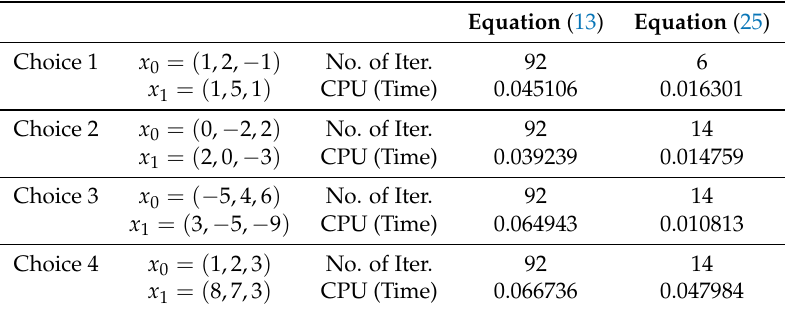
Table 1. Using Equations (13) and (25) with different choices of x 0 and x 1 .